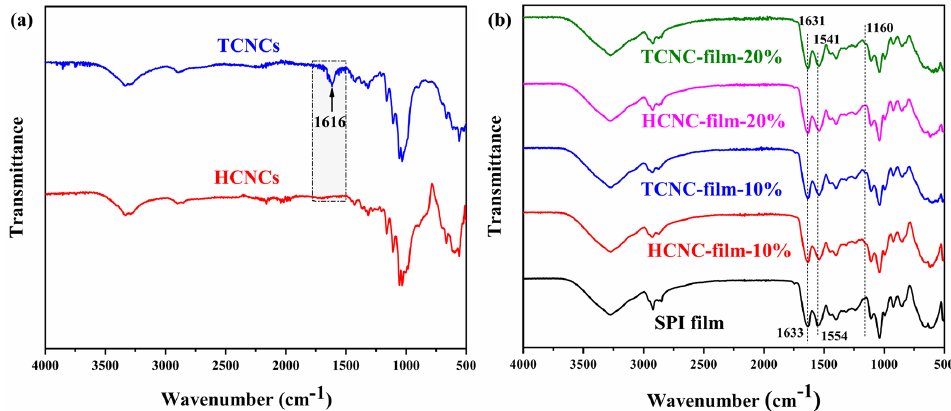
Figure 4. Fourier-transform infrared spectroscopy (FT-IR) spectra of ( a ) HCNCs and TCNCs, and ( b ) SPI and SPI/CNC